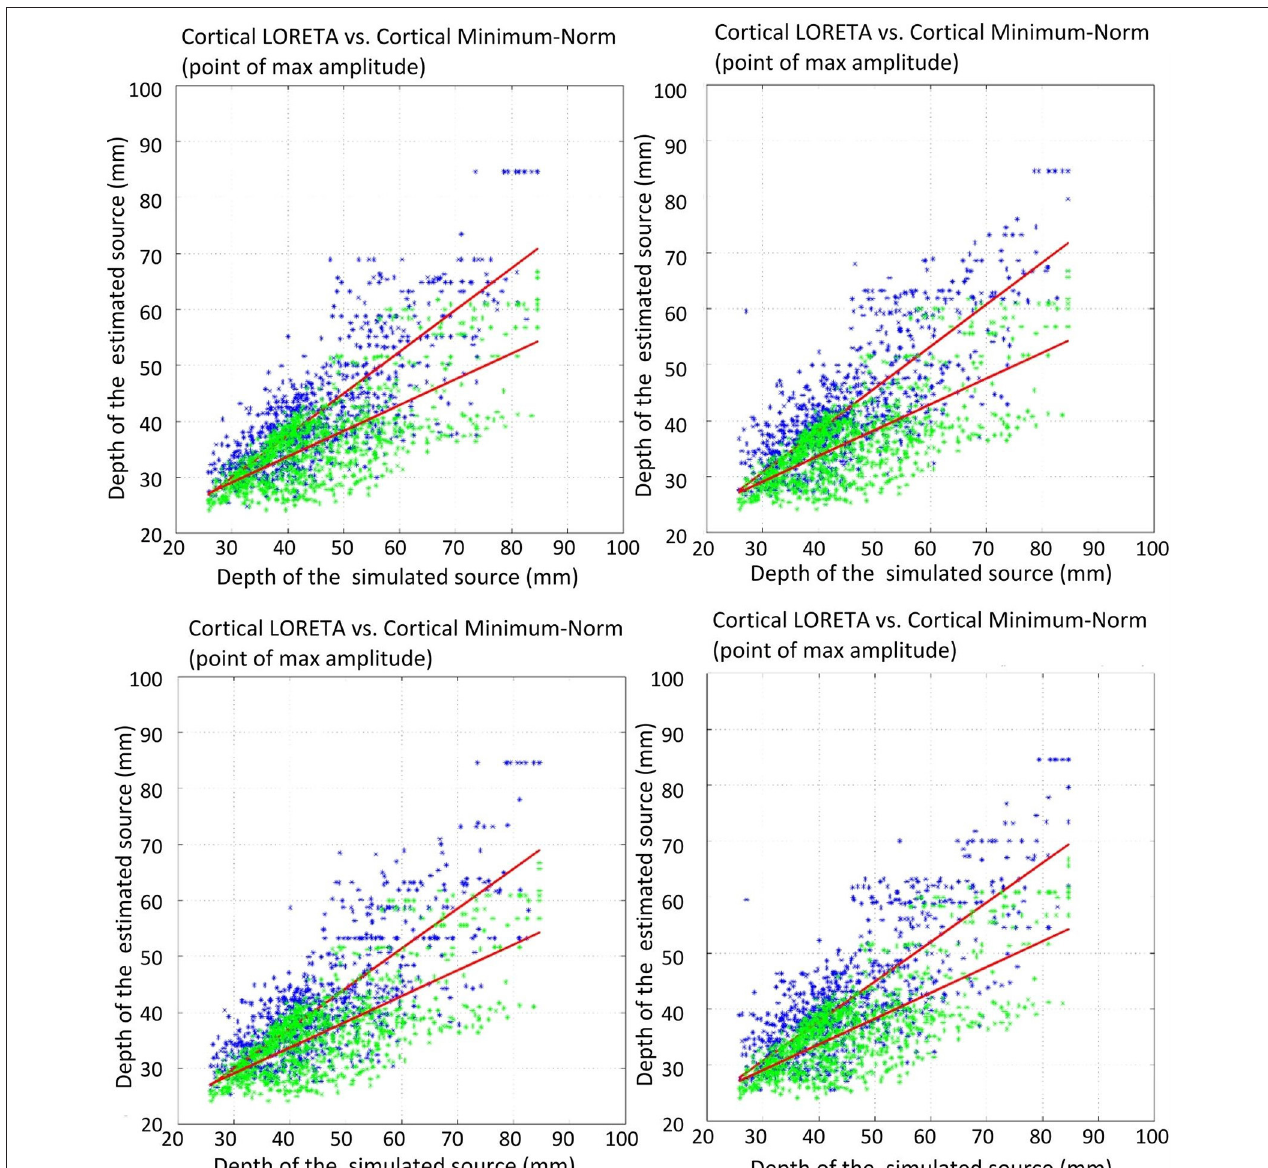
FIGURE 7 | Correlation of the estimated source depth (point of max amplitude) with the simulated source depth. Green shows minimum-norm, blue depicts LORETA. The plots show: top left, unweighted graph Laplacian; top right, weighted graph Laplacian; bottom left, unweighted geometric Laplacian; bottom right, weighted geometric